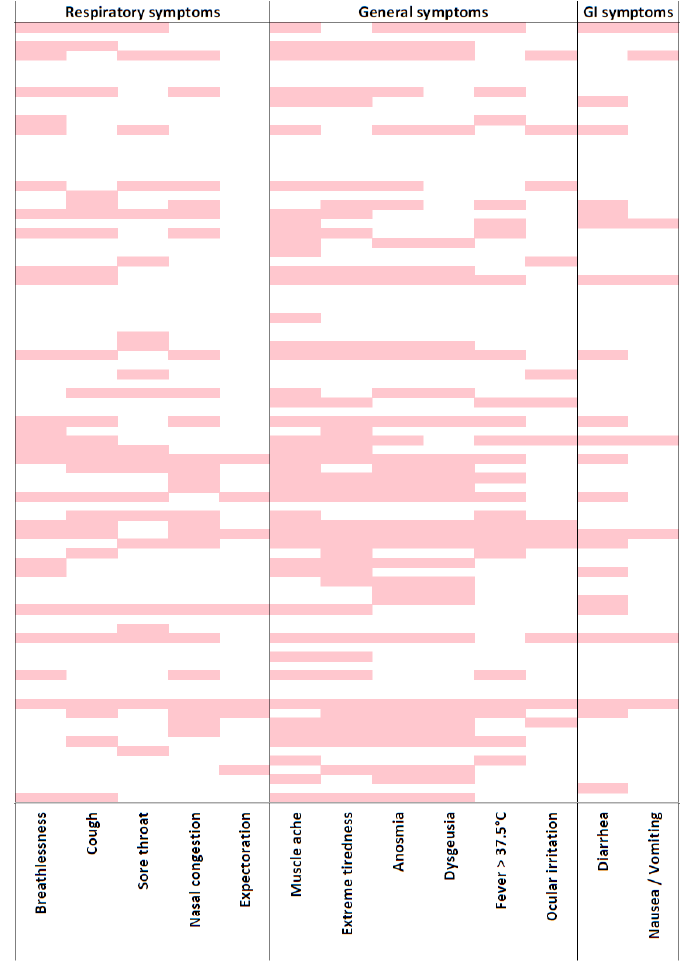
Figure 1. Heatmap of early symptoms reported by healthcare workers positive for SARS-CoV-2. Symptoms were grouped as respiratory, general, and gastrointestinal symptoms. Pink: symptom was present; white: symptom was absent. GI: gastro intestinal.